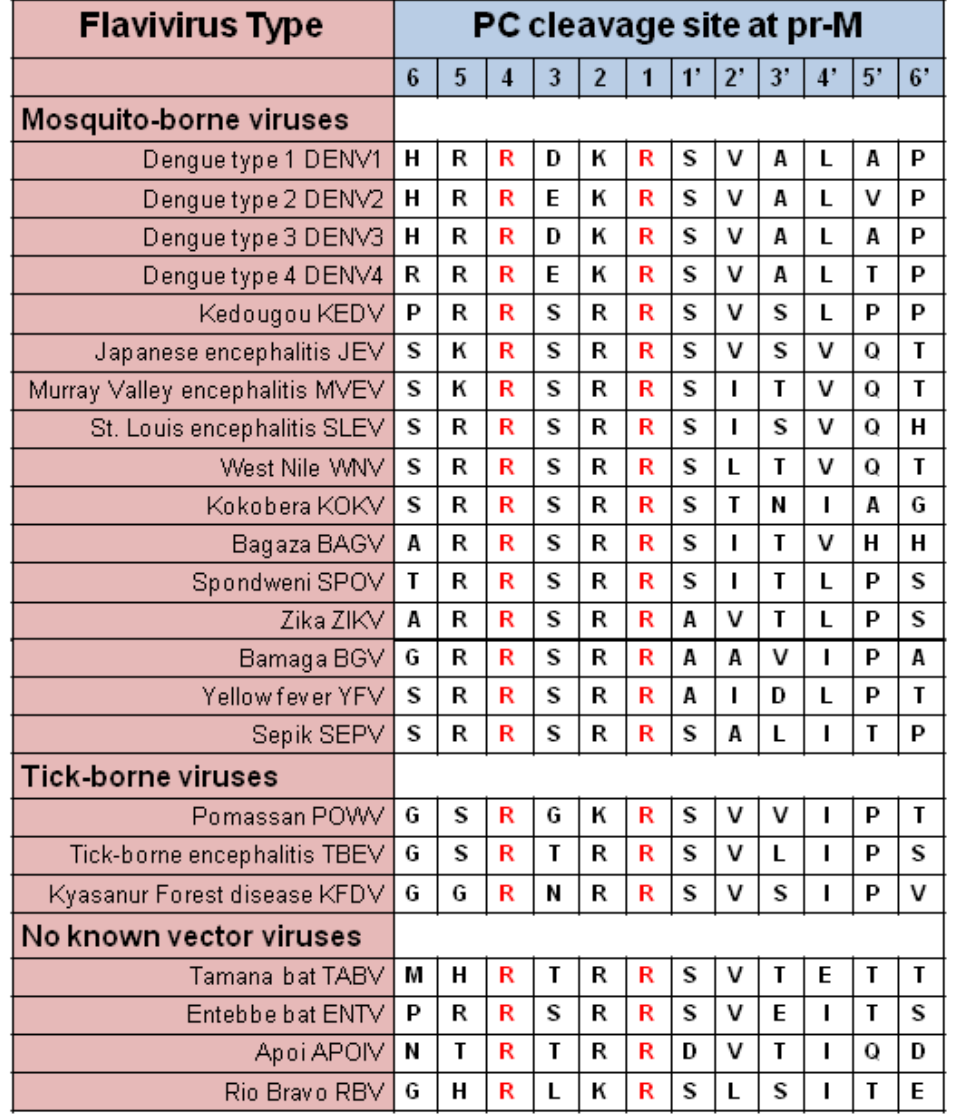
Table 4. Alignment of flavivirus PC cleavage sites.